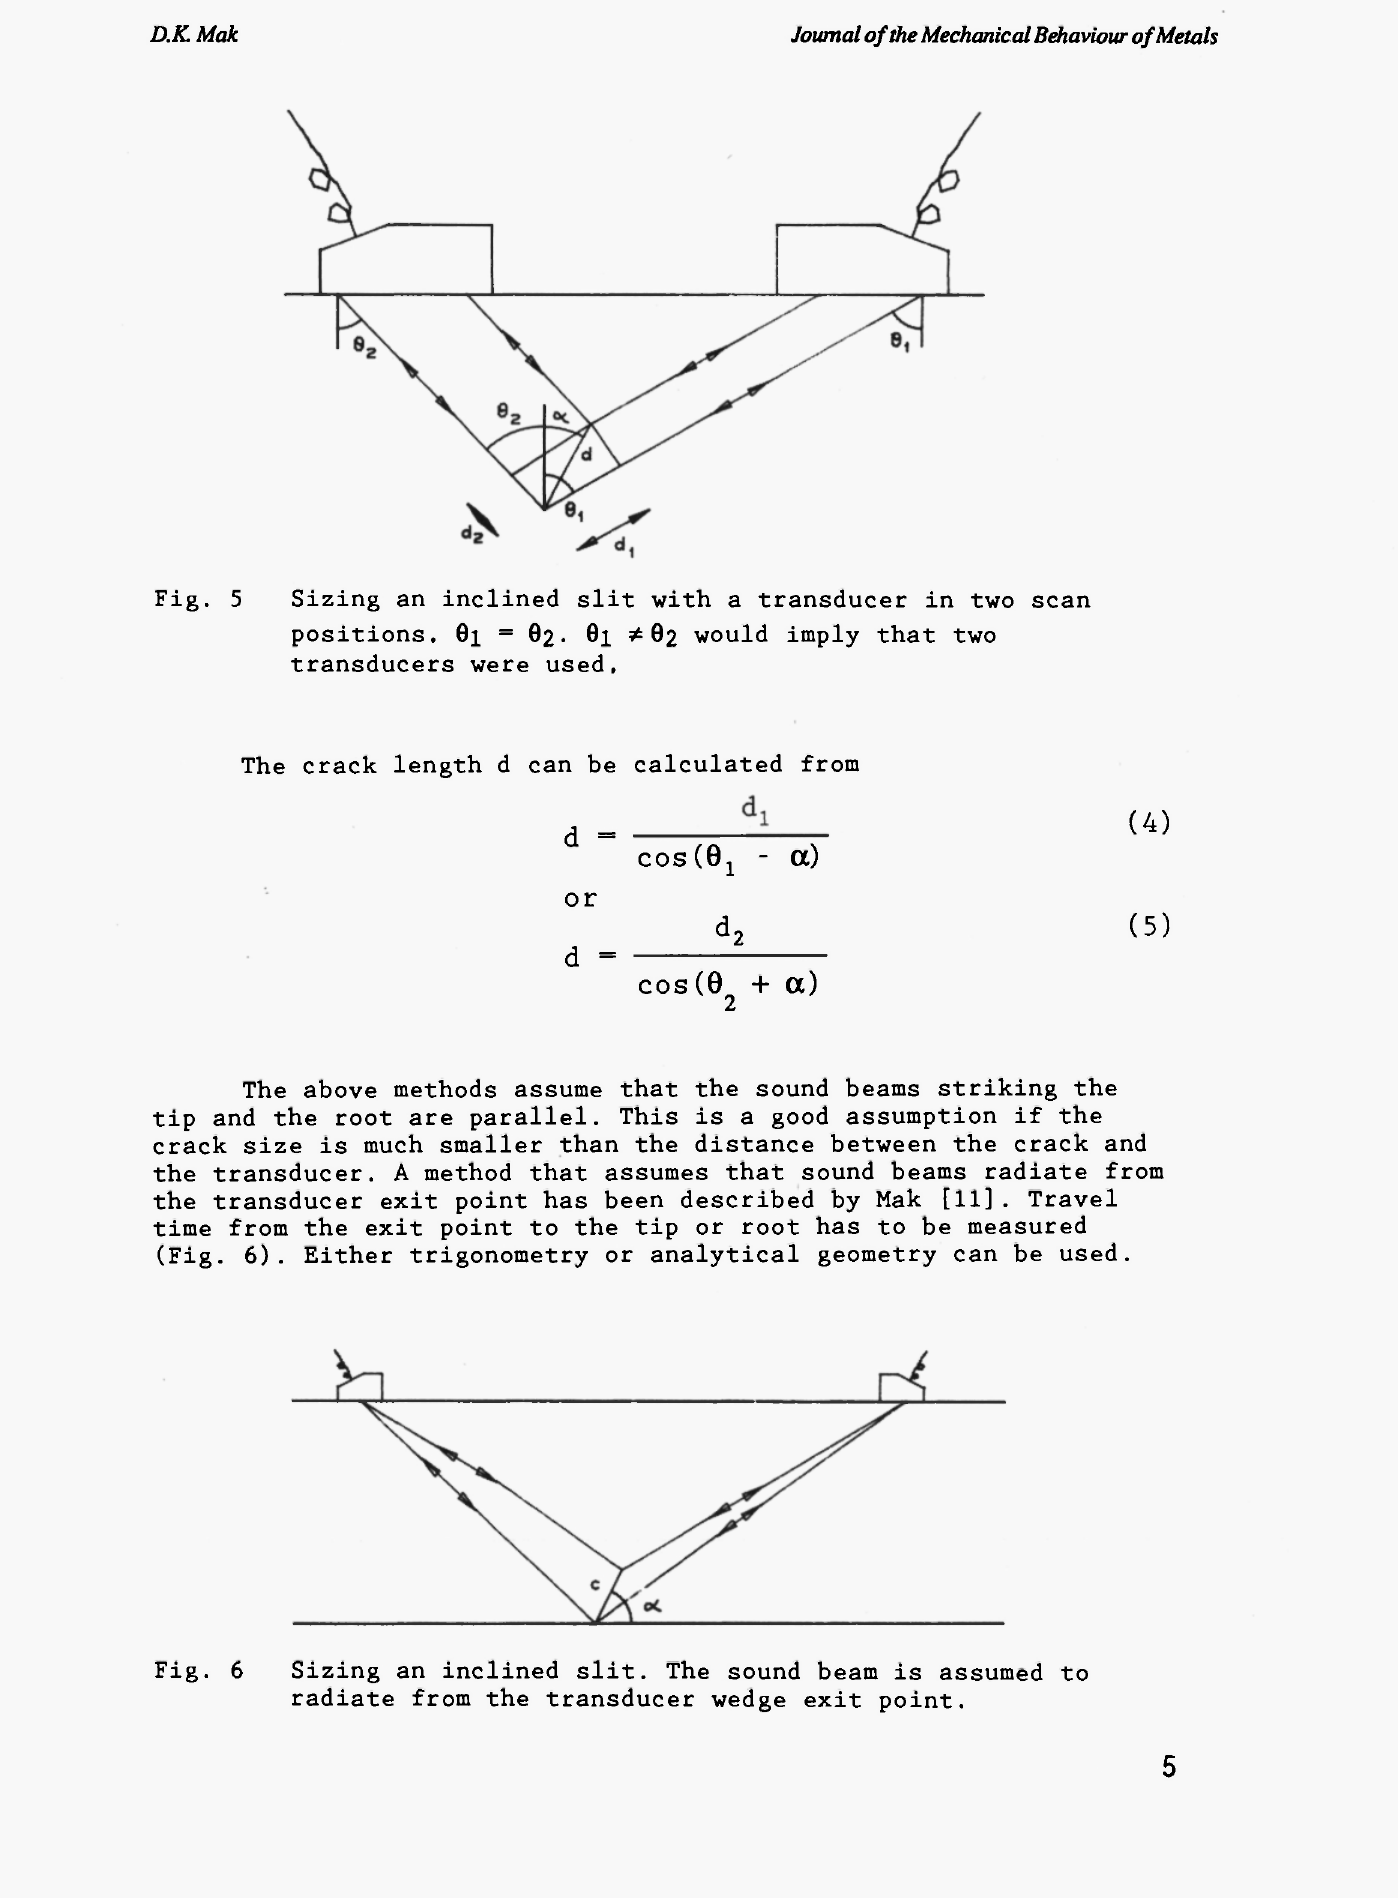
Fig. 6 Sizing an inclined slit. The sound beam is assumed to radiate from the transducer wedge exit